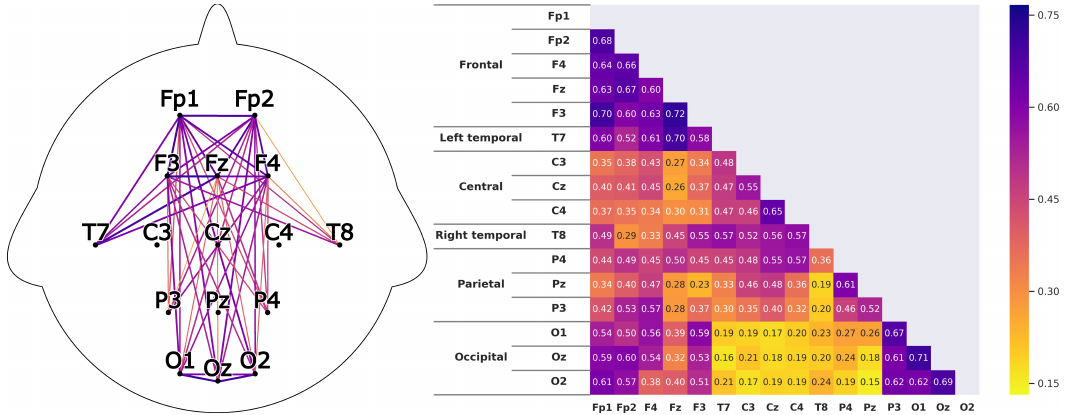
Figure 9. Correlations as described in Figure 8 for the BSC